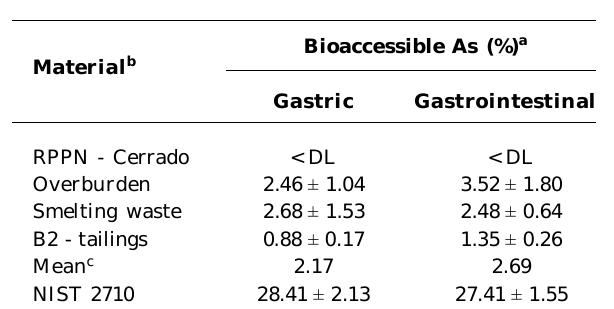
Table 1. Bioaccessible arsenic in samples from a gold mining area